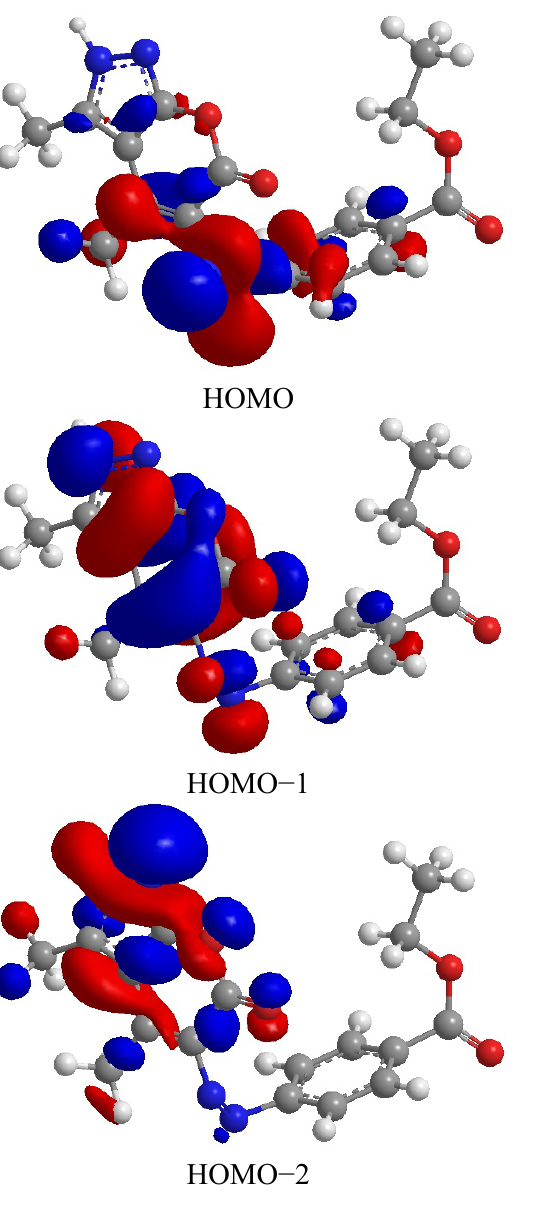
Figure 3. Highest Occupied molecular orbital and the lowest unoccupied molecular orbital of compound 8 .